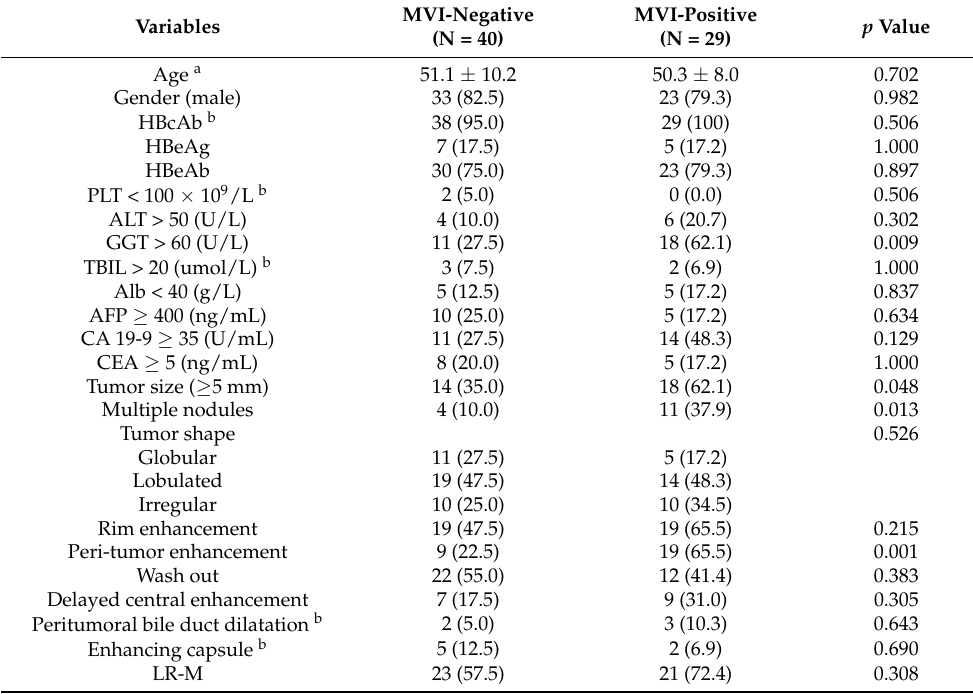
Table 1. Clinical and imaging characteristics of HBV-related cHCC-CCA patients according to MVI.